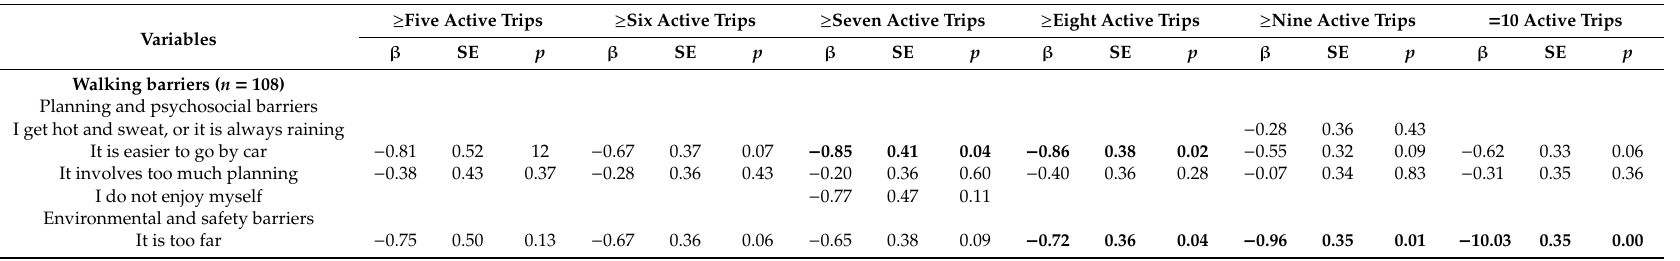
Table 2. Multivariate binary logistic regression analysis of di ff erent active trip cut-o ff criteria based on children’s active commuting to school (ACS) barriers.